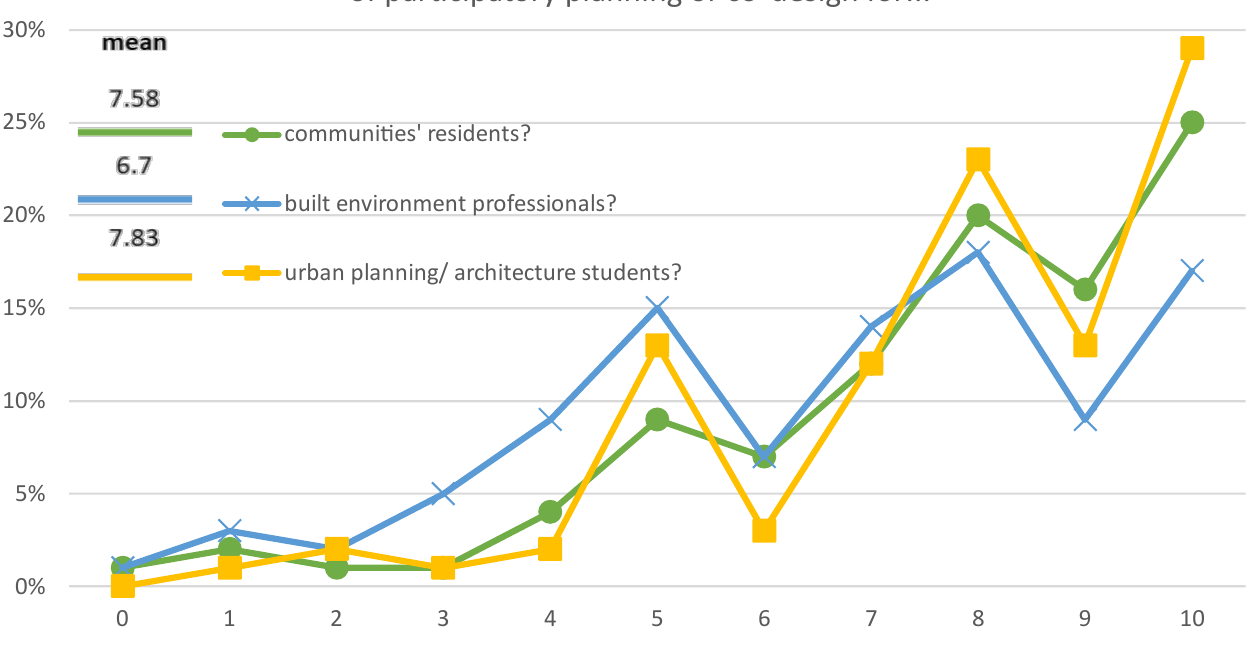
Figure 12. Perception of usefulness of gamified methodologies in the built environment.